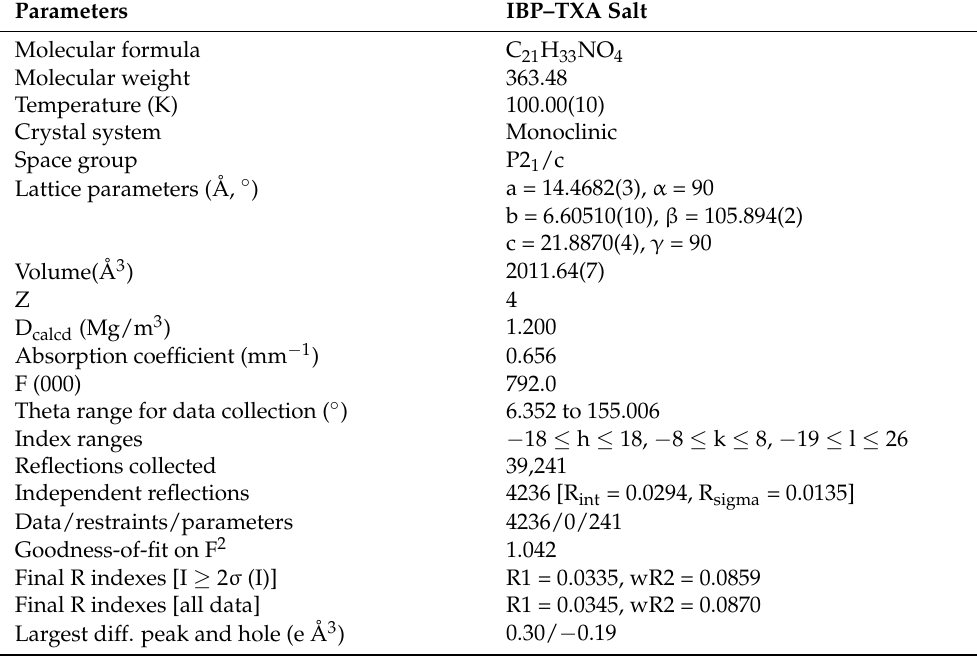
Table 2. Crystallographic data for the IBP–TXA salt.